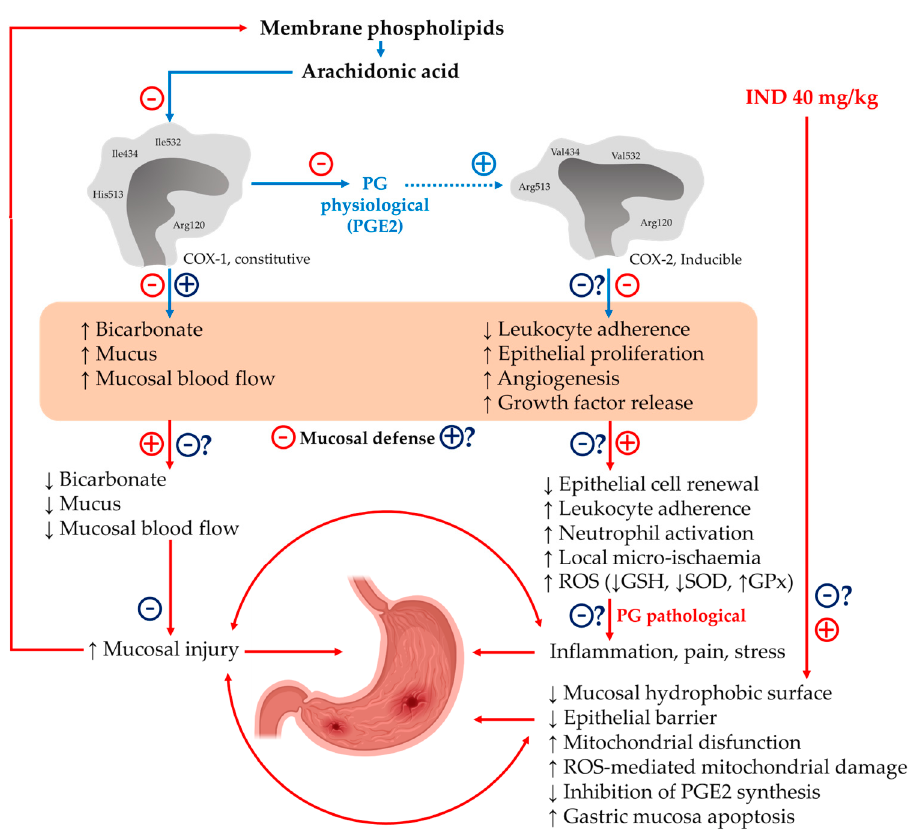
Figure 5. Critical points in the development of an indomethacin-induced gastric ulcer. The main steps in the development of IND-induced GU (red symbols and arrows) in which PBPs could act to exert their antiulcerogenic effects (dark-blue symbols) within the normal maintenance of gastric mucosa (blue symbols and arrows) are shown. Arachidonic acid is released from the phospholipids of lipid membranes. It is then oxidized by COX-1 to various prostaglandins, mainly PEG2, to regulate and maintain mucosal defenses and thereby ensure the integrity of the membranes. In this scenario, the administration of IND blocks the synthesis of PGE2 thus decreasing the secretion of protective substances such as gastric mucus, bicarbonate, and mucosal blood flow. This increases ROS production, mitochondrial damage, and apoptosis; generates painful inflammatory processes; and increases susceptibility to mucosal damage. Likewise, PBPs could reduce the harmful effects derived from COX-1 and COX-2 inhibition, thereby reducing mitochondrial damage and apoptotic processes and increasing angiogenesis and gastric epithelial renewal, among other